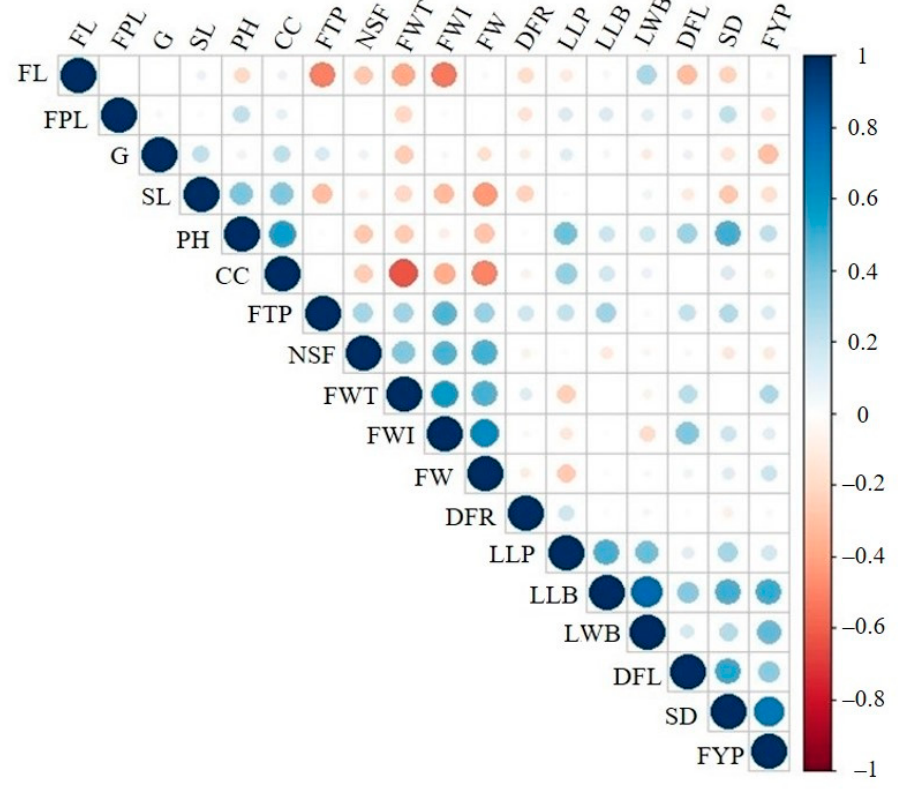
Figure 3. Pearson correlation matrix for the 18 quantitative traits of the 29 F1 lines and the